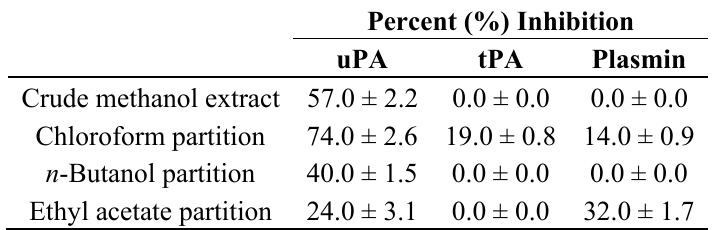
Table 4. Selectivity of the extracts of leaves of C. lucidus : inhibition of uPA and related